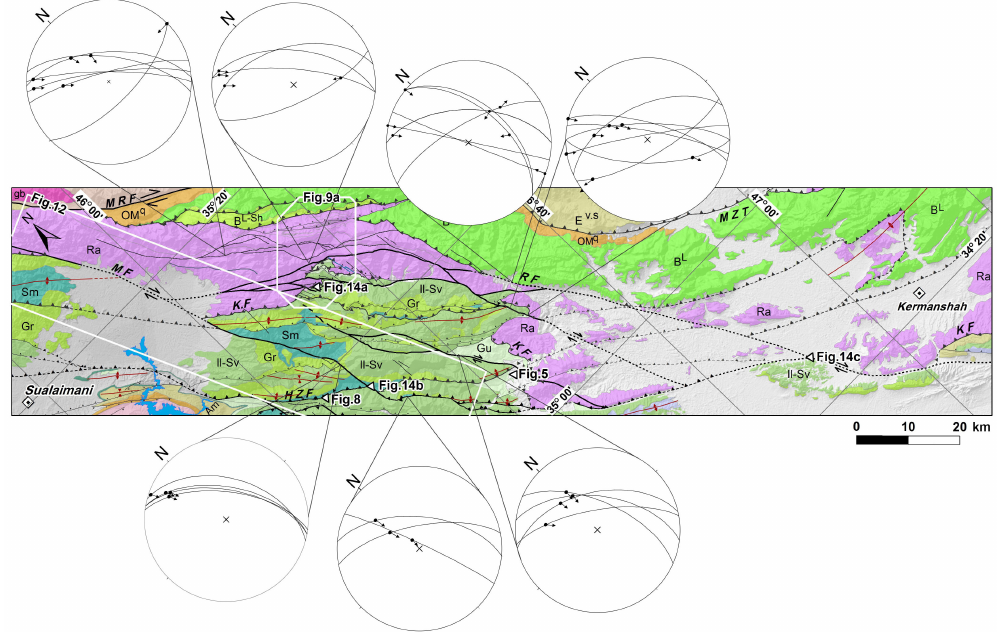
Figure 7. Structural map of the Kermanshah–Sulaimani (KS) area. Arrows in the lower hemisphere stereographic projections show the attitude of striae for movement direction of the late strike-slip fault of the late strike-slip faults. Abbreviations: MZT – Main Zagros Thrust; HZF – High Zagros Fault; KF – Kermanshah Fault; MRF – Main Recent Fault; MF – Marekhil Fault; RF – Ravansar